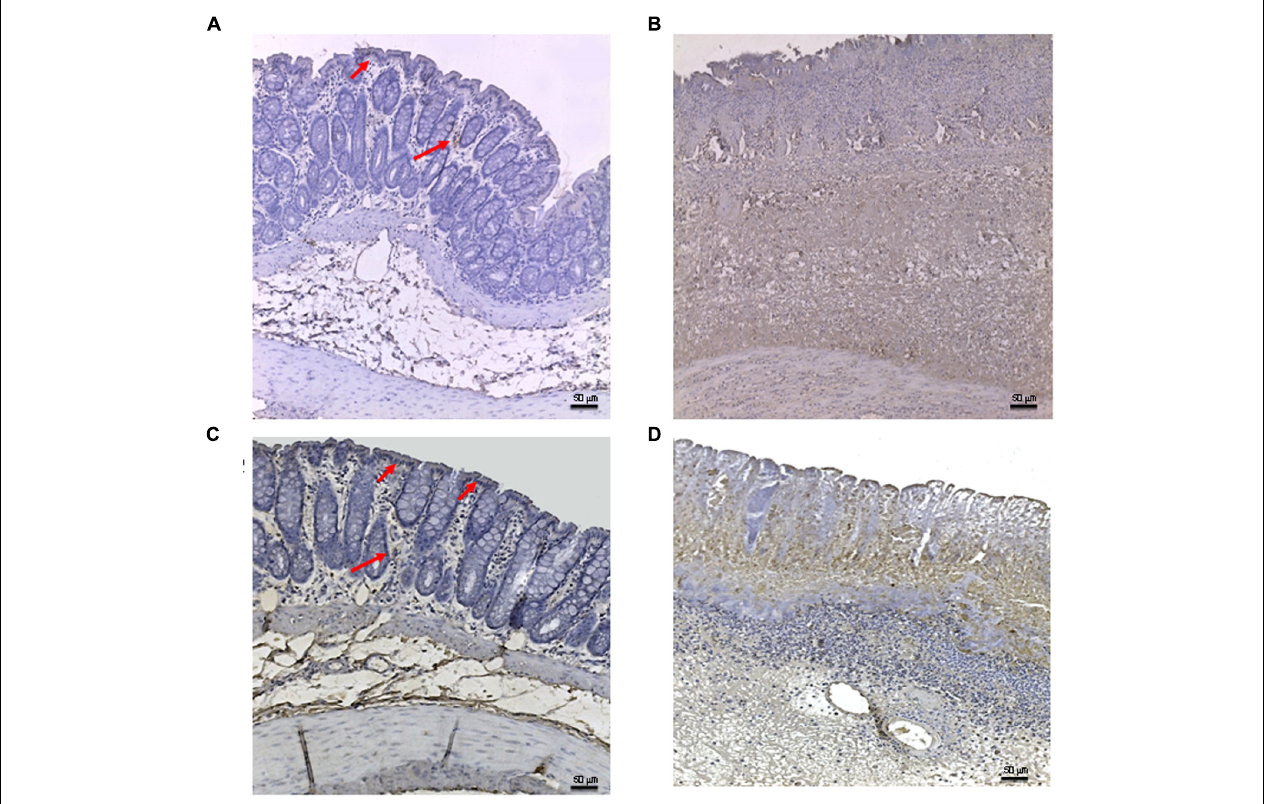
FIGURE 5 | Bax immunostaining from DNBS-treated animals. Representative Bax immunostaining (original magnification 10 × ) of colons derived from control (A) , DNBS + drug vehicle (B) , DNBS + PDRN (C) , or DNBS + PDRN + DMPX (D) treated animals are depicted. The arrows in (A) and (C) point to areas of slight positivity. The pictures in (B,D) demonstrate a diffuse staining for the apoptotic factor. Scale bar 50 µ